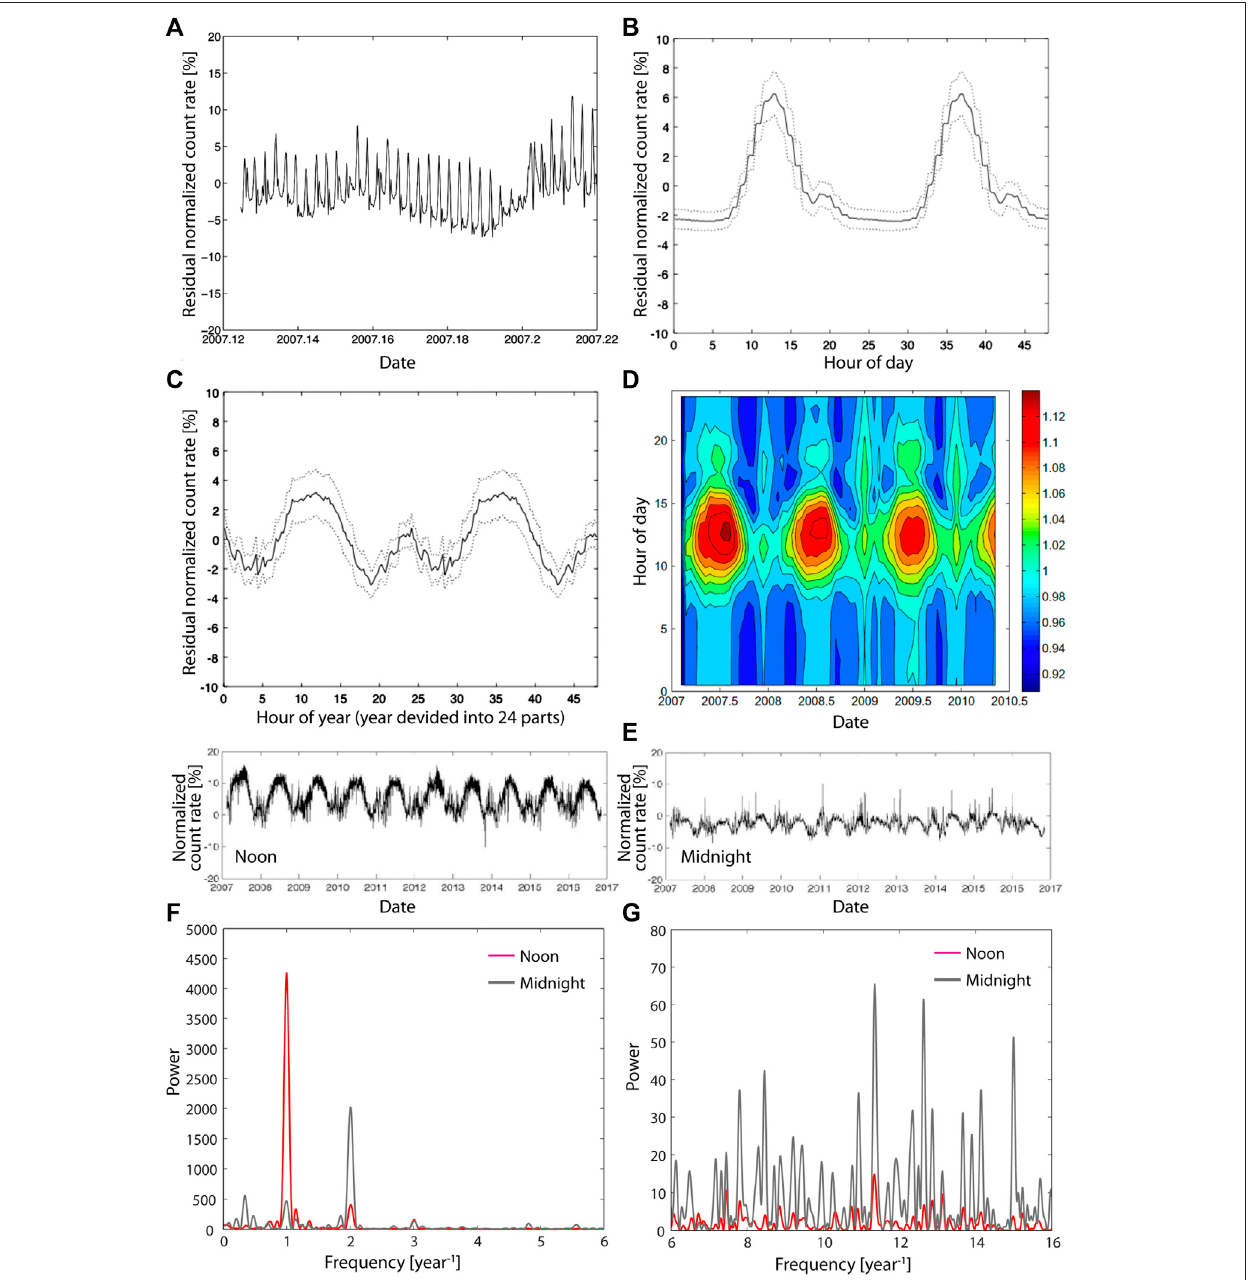
FIGURE2 |(A) Small section of c measurements, normalizedto mean value unity, percent deviation, asafunction oftime. Thesharp fl uctuationsrepresentdiurnal variations. (B) Residualofnormalized c measurements,inpercent,asafunctionofhourofday(repeatedforclarity).Thedottedlinesindicatetheupperandloweroffsetof ten times the standard error of the mean. (C) Residual of normalized c measurements, in percent, as a function of hour of year (repeated for clarity). The dotted lines indicatetheupperandloweroffsetoftentimesthestandarderrorofthemean. (D) β decaysignalasafunctionofdateandhourofday.Accordingtothis fi gure,the dominant contribution to the beta-decay measurements occurs near noon in or near June. Since they are traveling toward the Sun, they can only be cosmic neutrinos. (E) Residualsinpercentofthenormalized c measurementsmadeatnoon (upperpanel, hourofday11.00 – 13.00,meanvalue5.66%)andat midnight (lowerpanel, hour of day 23.00 to 1.00, mean value − 2.25%) as a function of date. Note that pulses occur only in the midnight data. (F) Power spectra formed from the 4-h band of measurements centered on noon (red) and midnight (blue) for the frequency band 0 – 6 year − 1 . We see that the biggest daytime oscillation is at 1 year − 1 ; the biggest nighttime oscillation is at 2 year − 1 . (G) Power spectra formed from the 4-h band of measurements centered on noon (red) and on midnight (blue) for the frequency band 6 – 16 year − 1 . We see that there are strong oscillations in the expected rotational frequency band 10 – 14 year − 1 (note especially the peaks at 11.35 year − 1 and 12.64 year − 1 ) in the nighttime data, but comparatively small oscillations in the daytime data. See Table 2 for detected frequencies in the nighttime data.